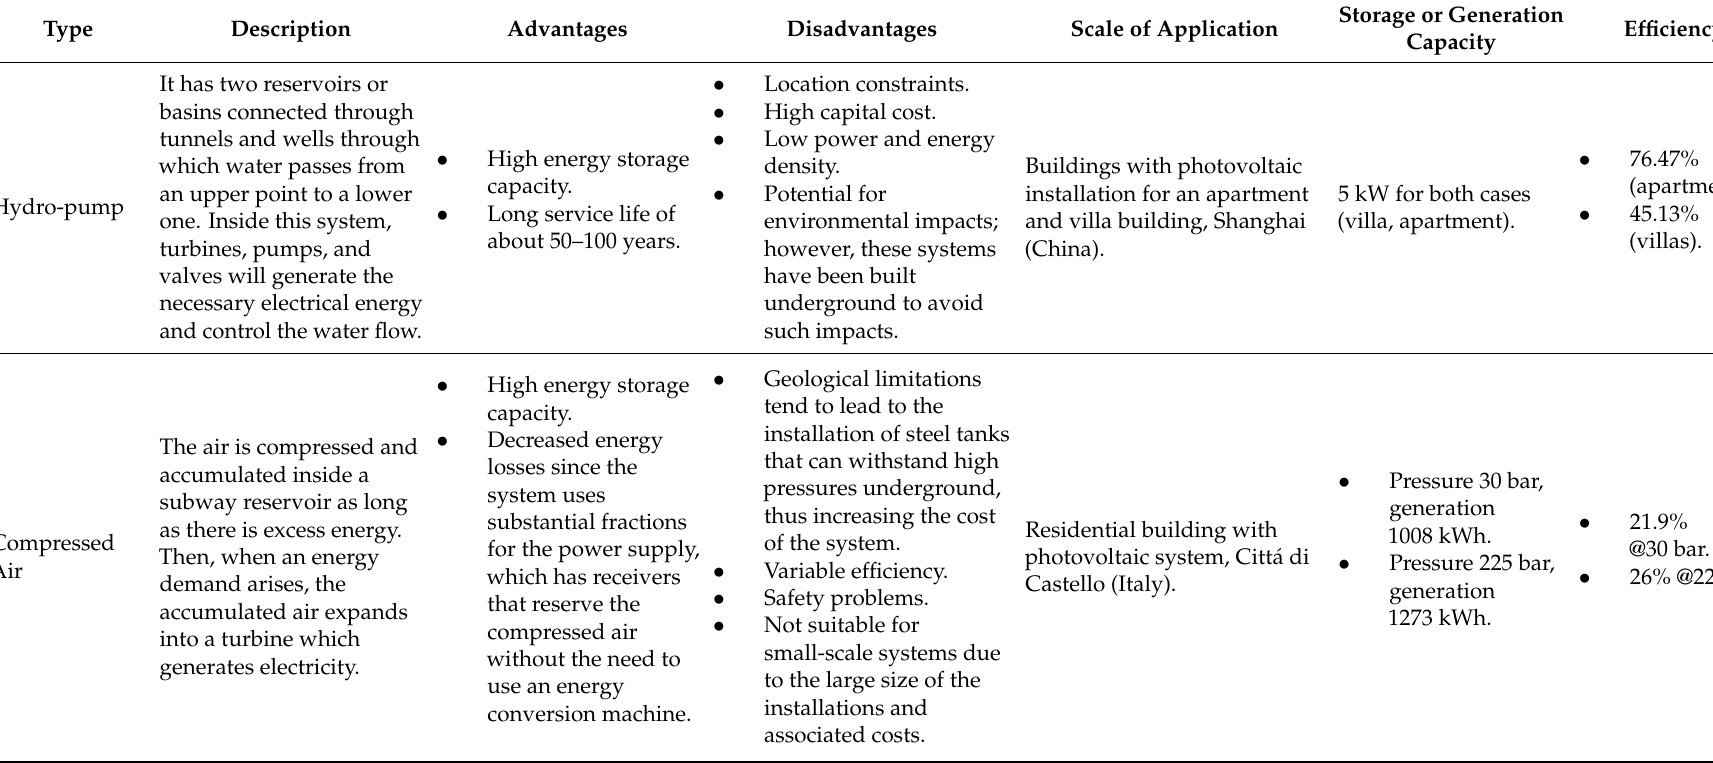
Table 2. Evaluation of conventional storage